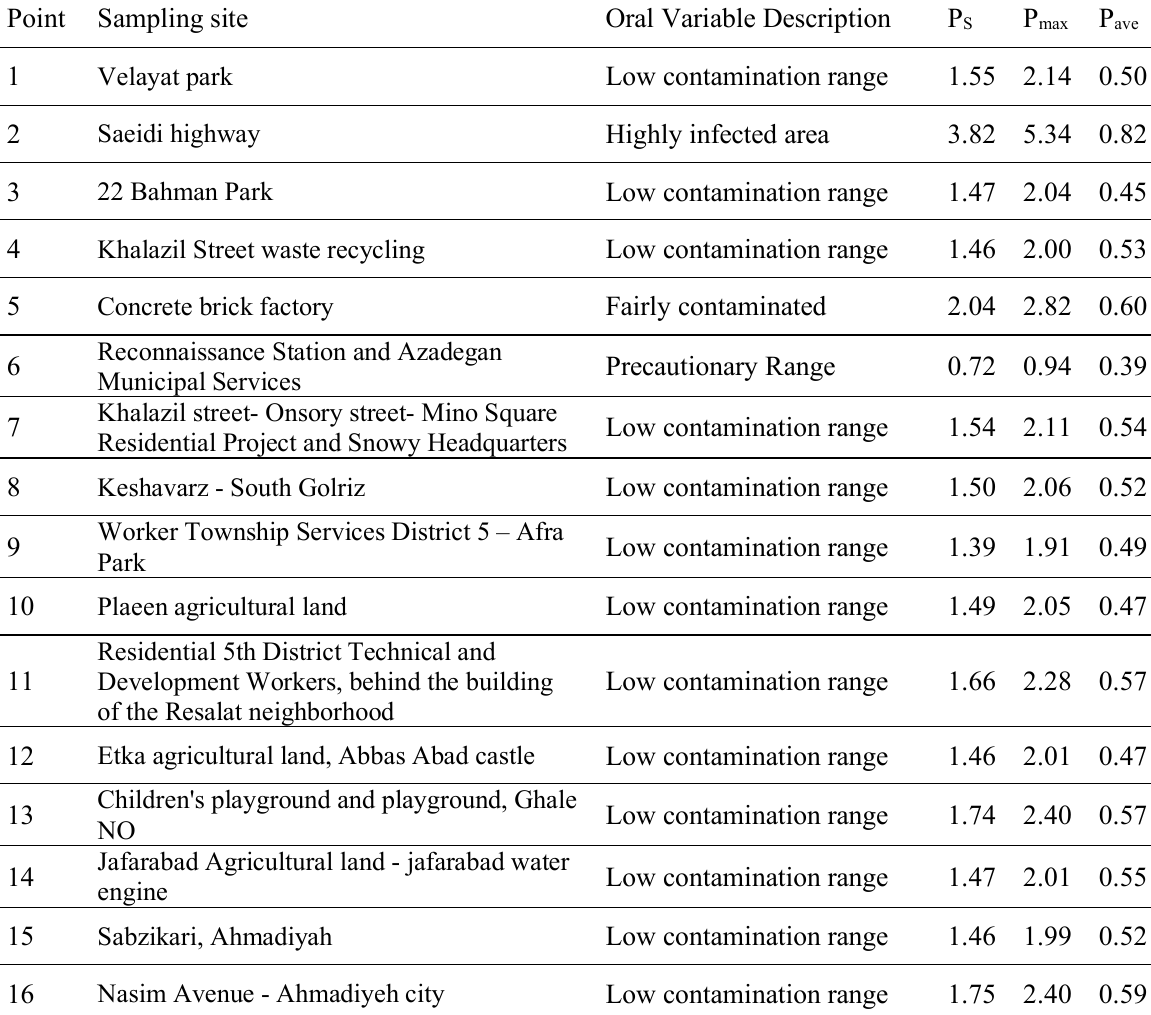
Table 11 . Calculation of the Nemerow Index and Classification of Soil Quality from Heavy Metals in the Target Points of the 19th District of Tehran Municipality